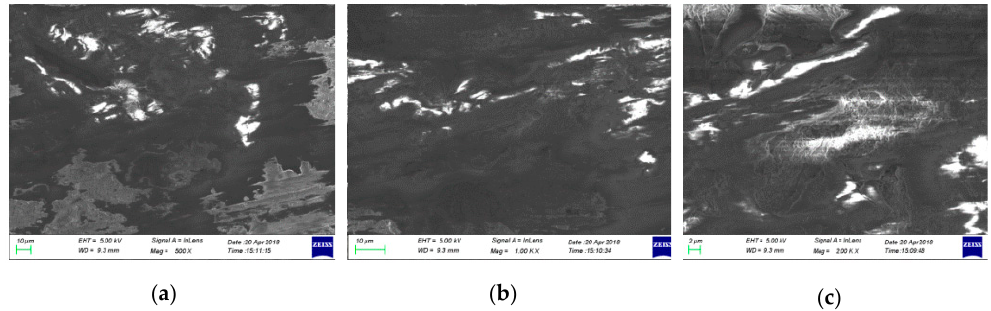
Figure 10. The surface morphology of AOF samples with the SEM: ( a ) 500 times; ( b ) 1000 times; ( c ) 2000 times.